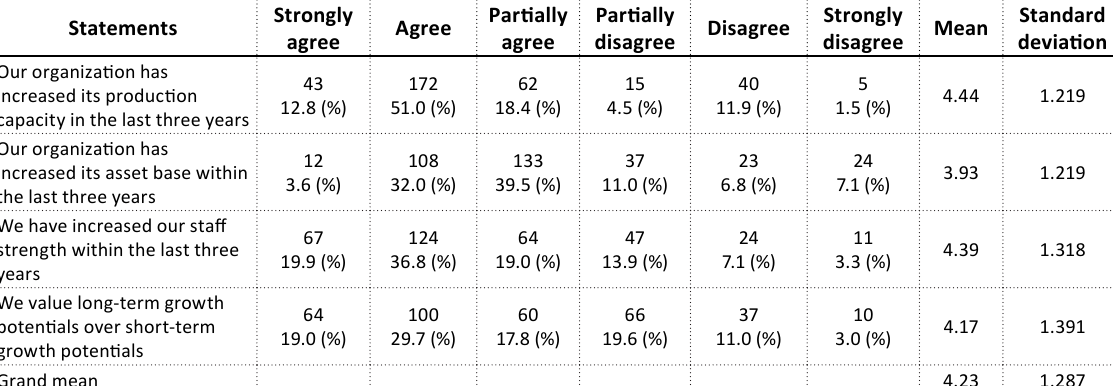
Source: Computed from field reports (2018).